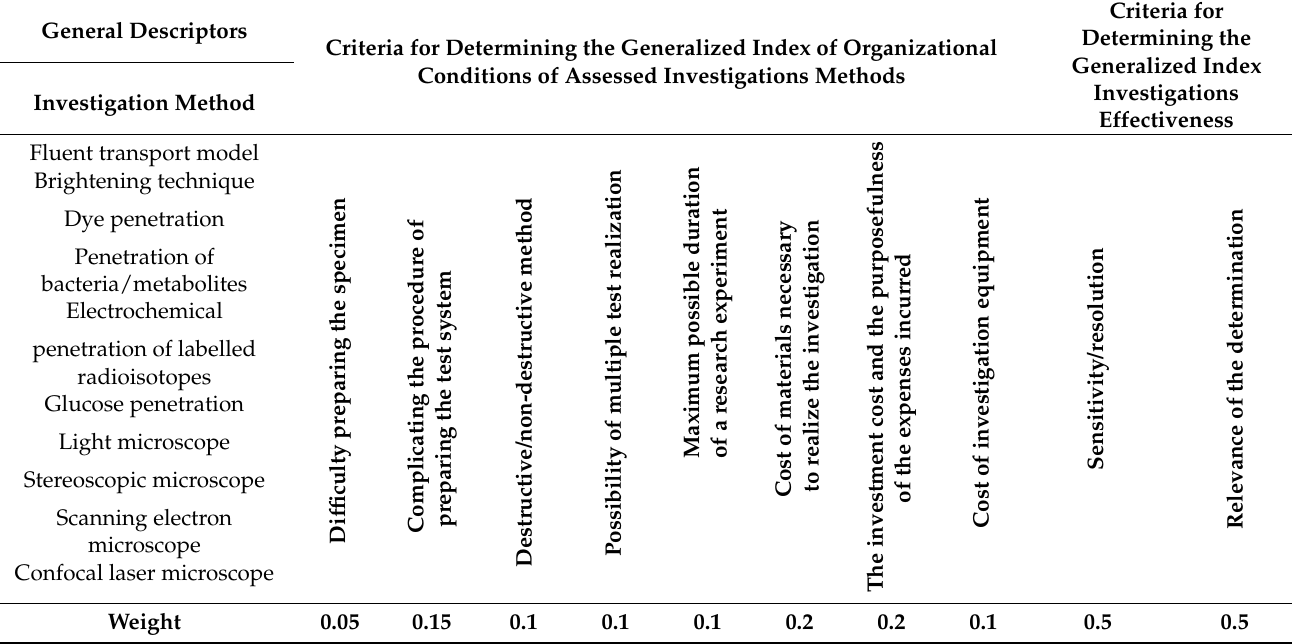
Table 5. The set of criteria adopted for the virtual contextual analysis concerning the selection of techniques of obturation during endodontic